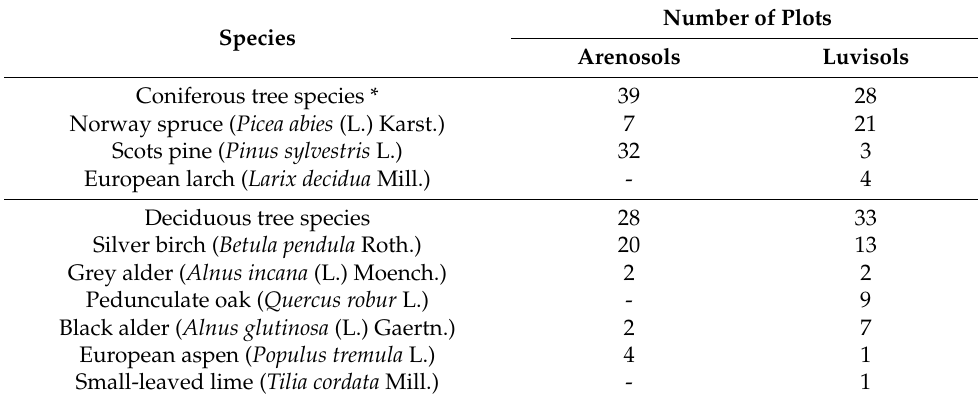
Table 1. Number of study plots selected for different coniferous and deciduous tree species. Number of Plots Species Arenosols Luvisols Coniferous tree species * 39 28 Norway spruce ( Picea abies (L.) Karst.) 7 21 Scots pine ( Pinus sylvestris L.) 32 3 European larch ( Larix decidua Mill.) - 4 Deciduous tree species 28 33 Silver birch ( Betula pendula Roth.) 20 13 Grey alder ( Alnus incana (L.) Moench.) 2 2 Pedunculate oak ( Quercus robur L.) - 9 Black alder ( Alnus glutinosa (L.) Gaertn.) 2 7 European aspen ( Populus tremula L.) 4 1 Small-leaved lime ( Tilia cordata Mill.) -